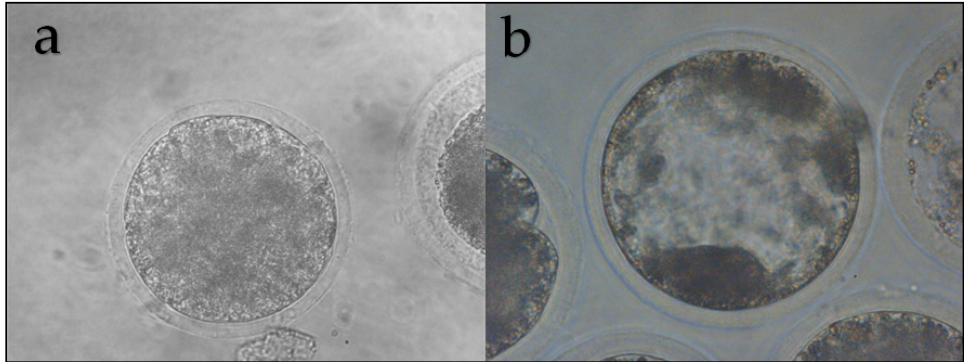
Figure 6. In vitro development of M. gouazoubira cloned embryos for the couples (fibroblast/cyto- plast): deer/goat ( a ) and deer/cattle ( b ).